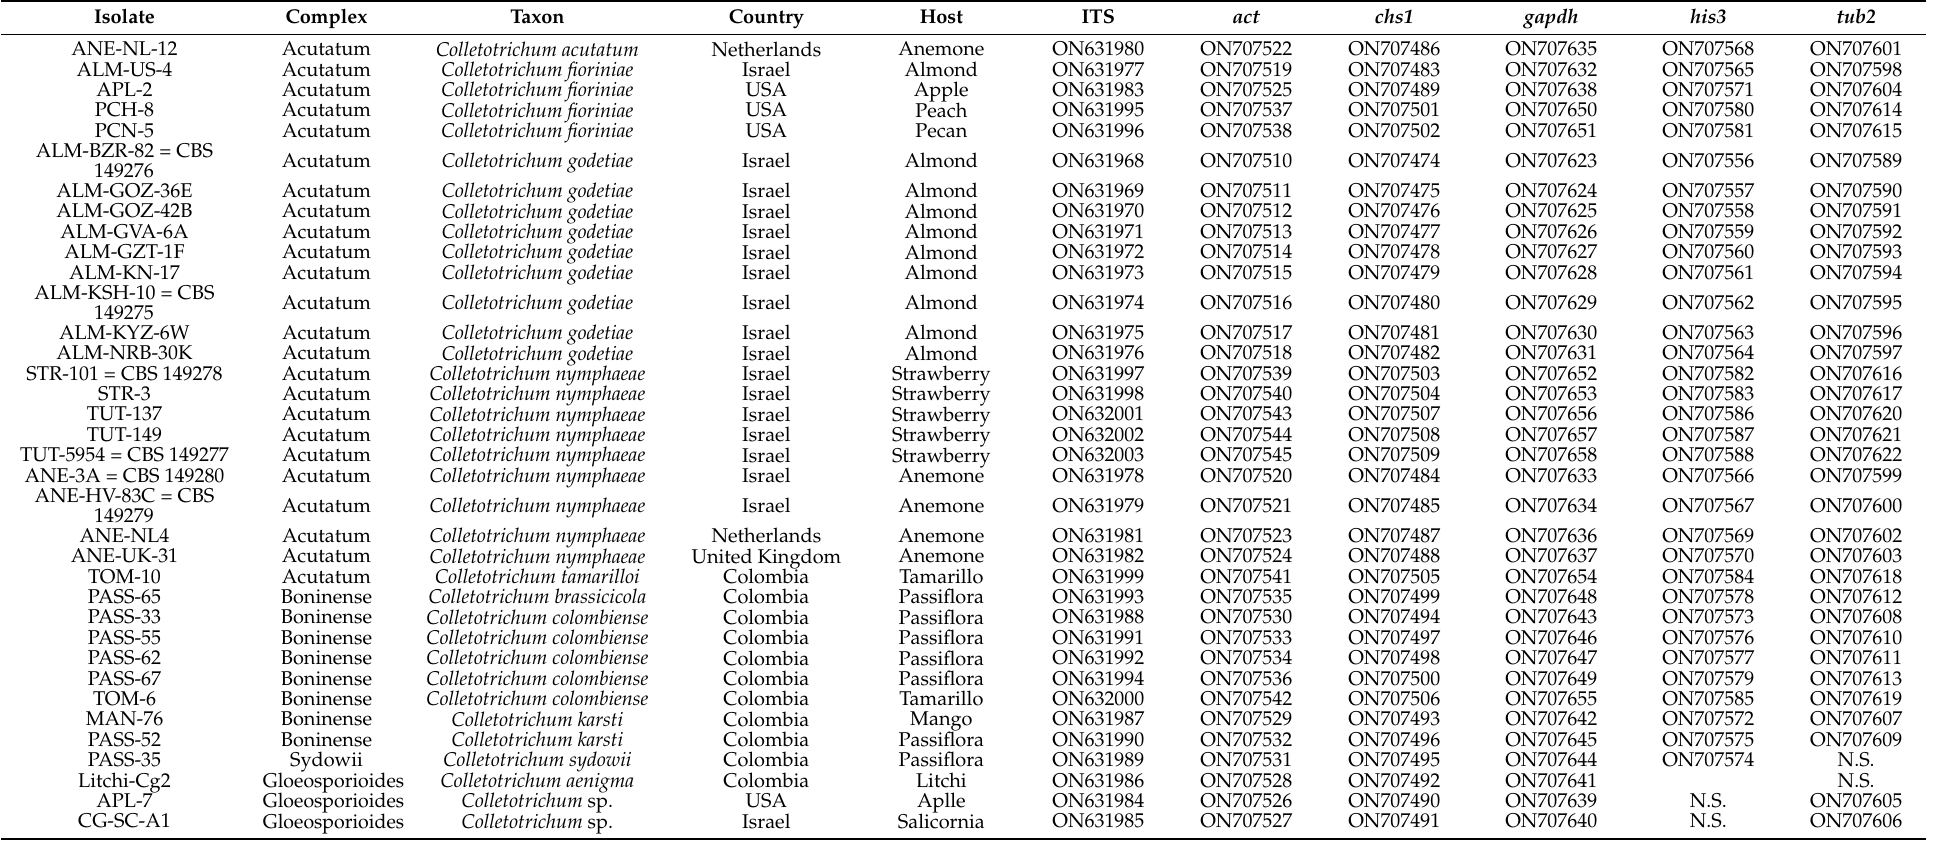
Table 2. Details of host, country of origin and species complex of Colletotrichum isolates used in the phylogenetic analyses along with the GenBank accession numbers of the sequences (N.S. = not